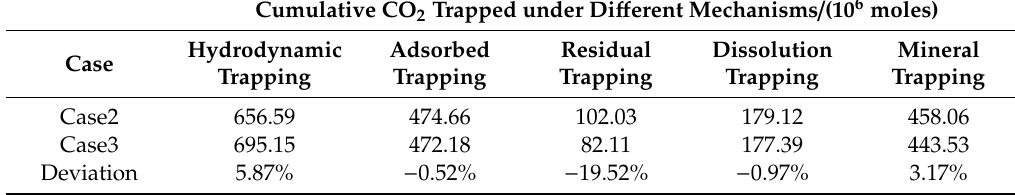
Figure 6. ( a , b ) Cumulative CO 2 storage under different mechanisms at different CO 2 injection rates; ( c , e , g ) free CO 2 distribution for case 2 at 30 years, 100 years and 500 years; and ( d , f , h ) free CO 2 distribution for case 3 at 30 years, 100 years and 500 years. Table 3. Comparison of CO 2 amount in di ff erent phases for case 2 and case